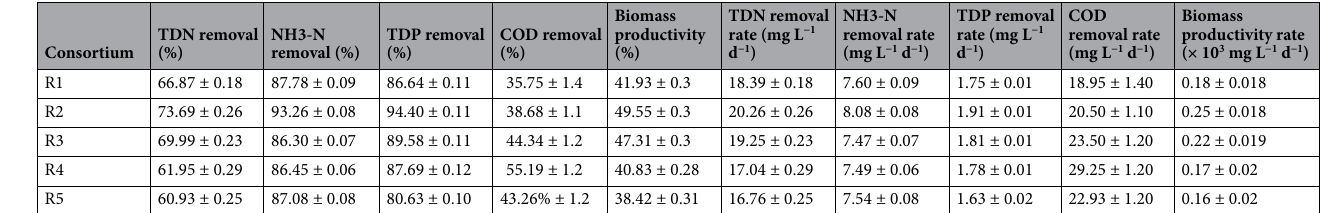
Table 1. The wastewater removal efficiency and biomassproductivity for consortia with different algae/ activated sludge